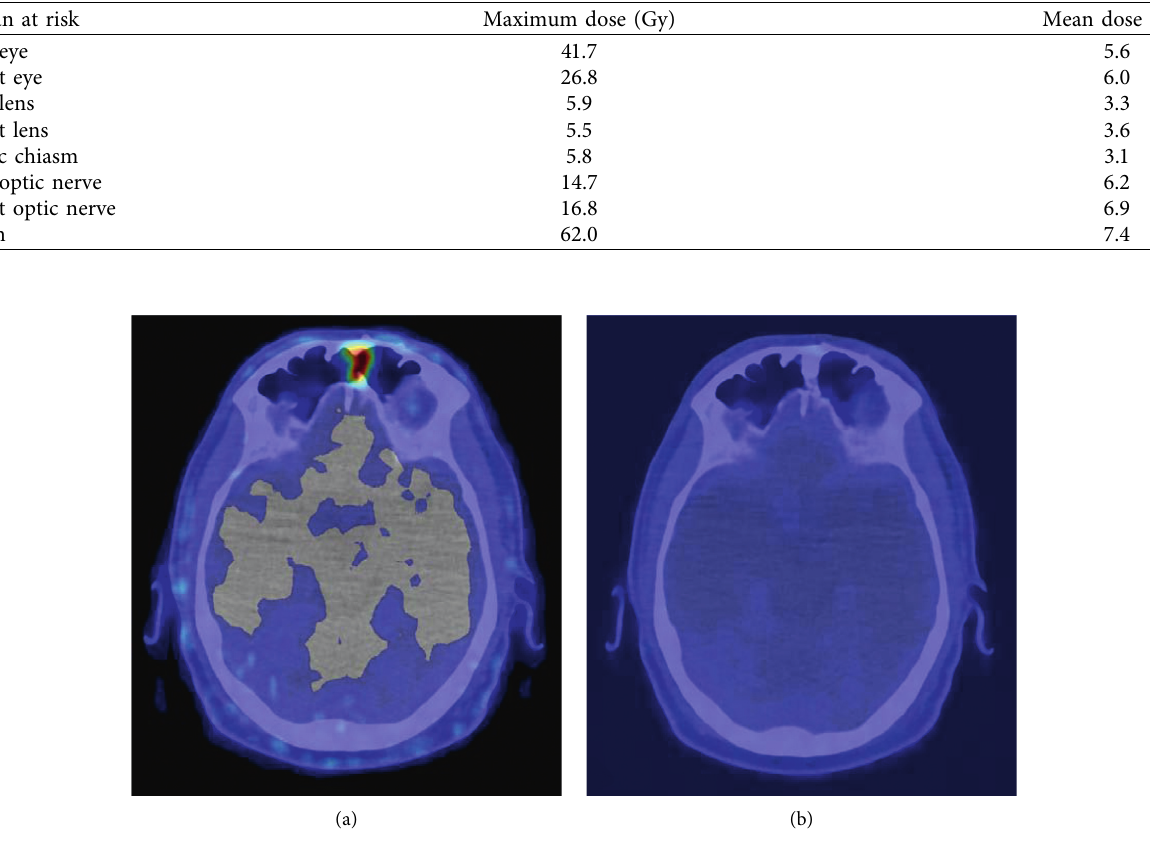
Figure 2: 68 Ga-DOTATATE PET-CT images showing complete response of the recurrent ossifying fibromyxoid tumor in the left frontal sinus after surgery and adjuvant radiotherapy. 68 Ga-DOTATATE PET-CT images before treatment (a) and after treatment